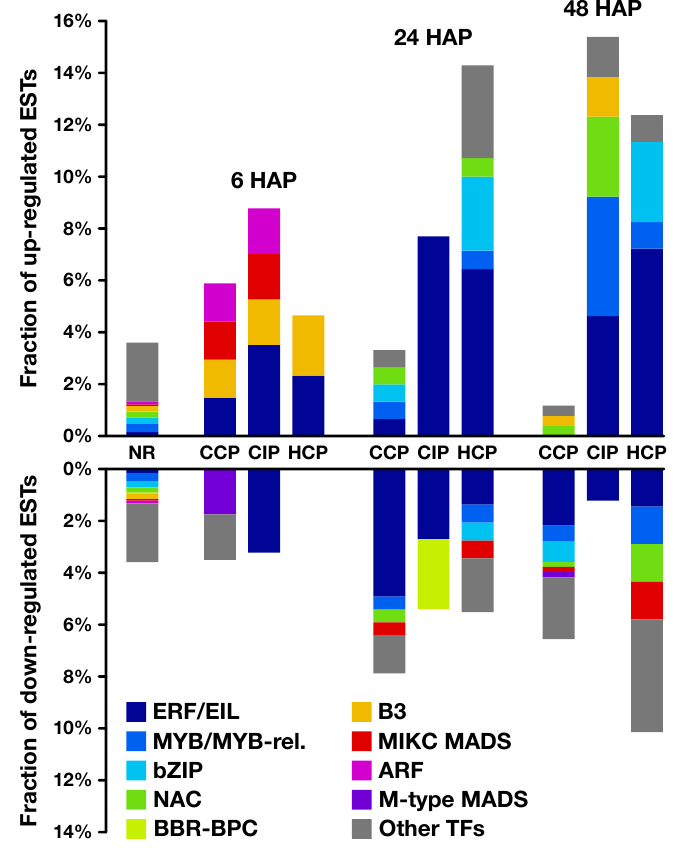
Figure 6. Transcription factor (TF) predictions on regulated genes. For each time point and each pollination condition, proportion of up- ( top ) and down-regulated ( bottom ) genes predicted to encode transcription factors belonging to different families, as identified by the PlantTFDB prediction tool. Corresponding data on non-regulated ( NR ) transcripts is shown as a reference. ARF: auxin response factor; BBR: barley b recombinant; BPC: BASIC PENTACYSTEINE1; bZIP: basic